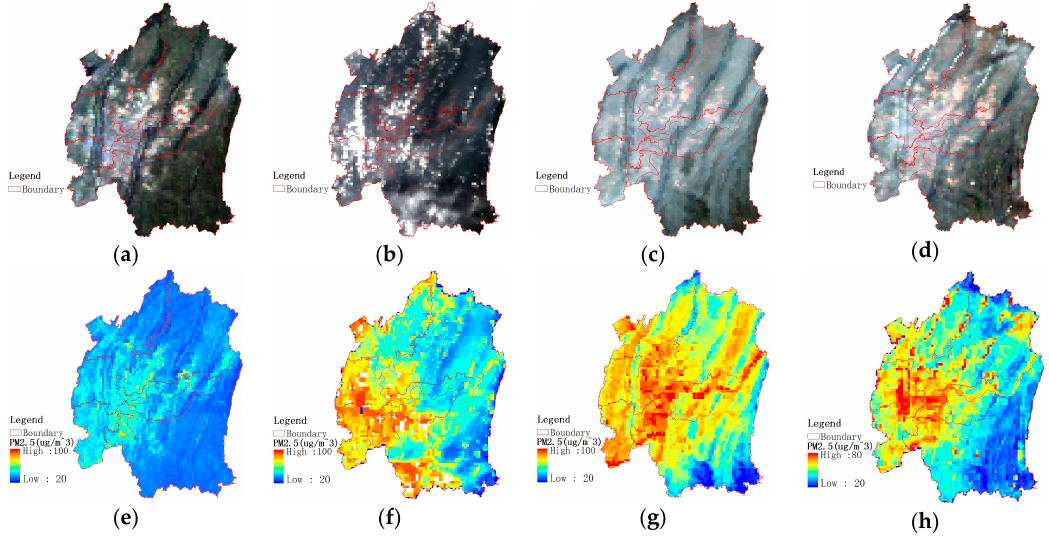
Figure 9. The true color ( a – d ) and PM 2.5 concentration ( e – h ) on 30 July 2014, 10 September 2014, 12 February 2015, and 28 April 2015, in sequence.